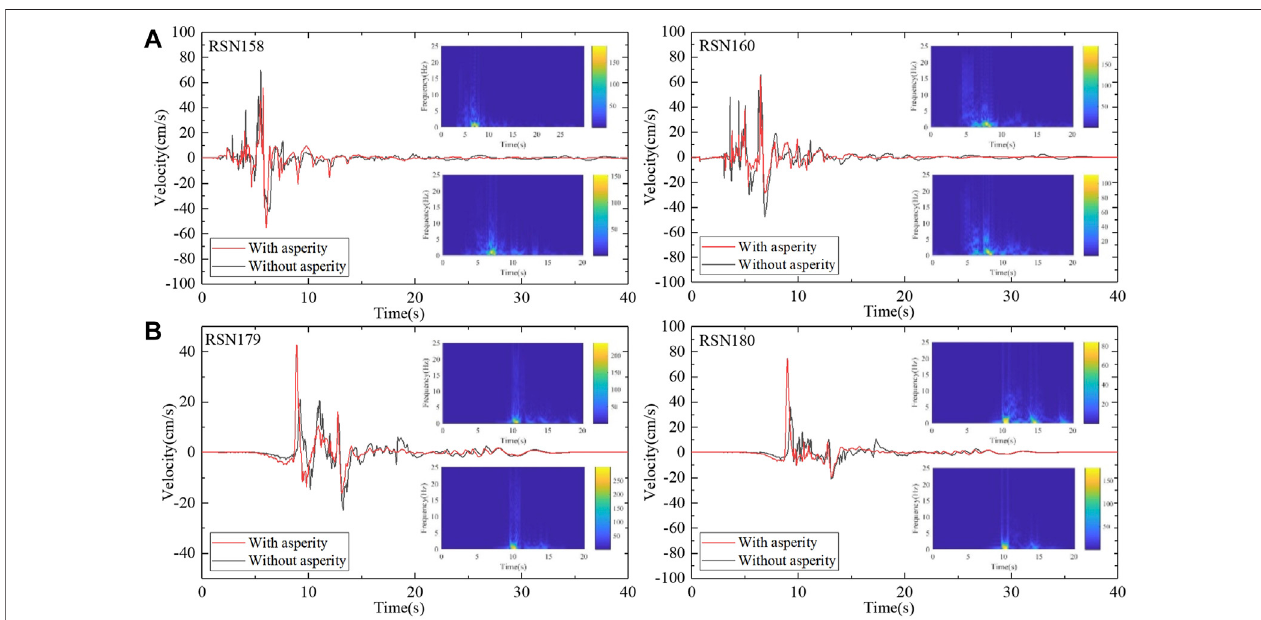
FIGURE 10 | Velocity time histories and time-frequency spectra for (A) near-epicenter stations and (B) rupture direction stations. The red and the black lines represent thesimulated velocity time historiesfrom theinhomogeneous and homogeneousslip distributions, respectively. The diagram in theupper right-hand corner is thetime-frequencyanalysisspectrumfromastationwithatimeseriesgeneratedbyahomogeneousslipdistributionandthediagraminthelowerright-handcorneristhe time-frequency analysis spectrum from a station with a time series generated by an inhomogeneous slip distribution. The color bar represents the amplitude of the Fourier spectra.